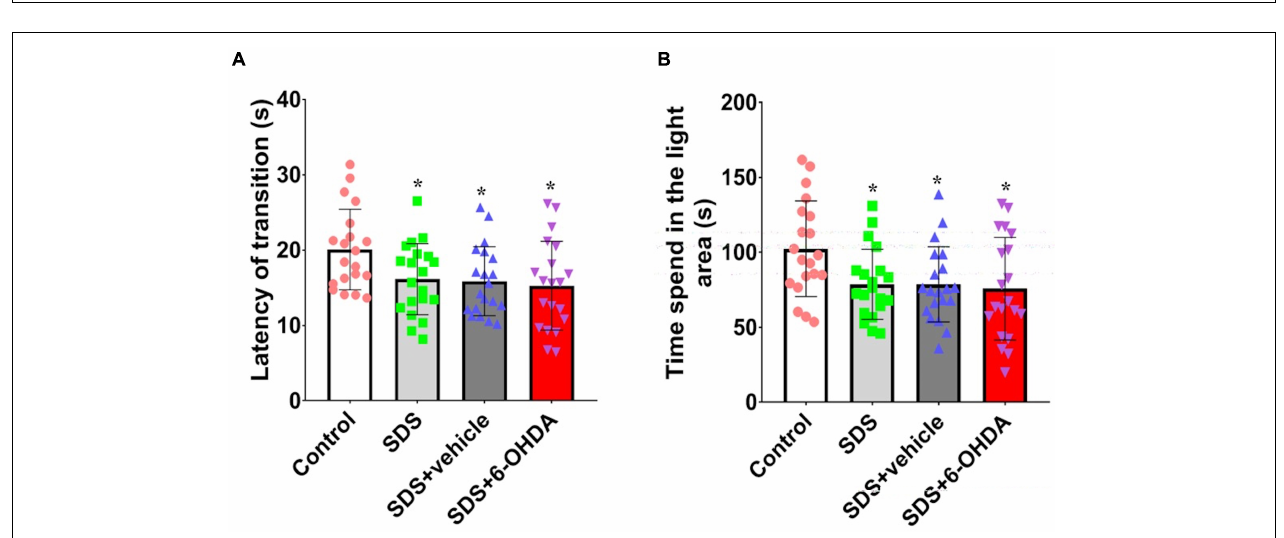
FIGURE 5 | Effect of social defeat stress on locomotion in the 6-OHDA lesioned mice. (A) , Activity distance; (B) , Time of activity in the center. * p < 0.05, ** p < 0.01, compared with the control group ( n = 20 per group).